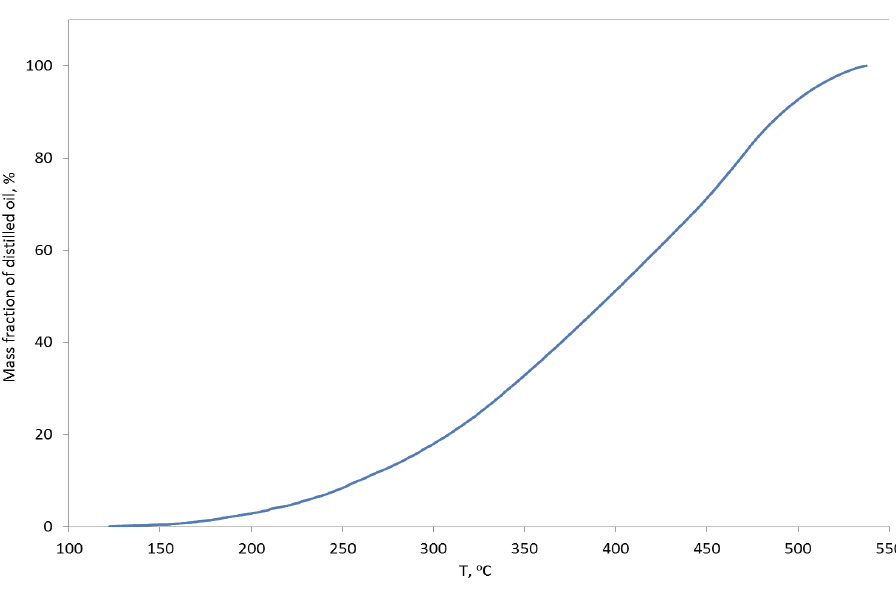
Fig. 2. Oil sample distillation